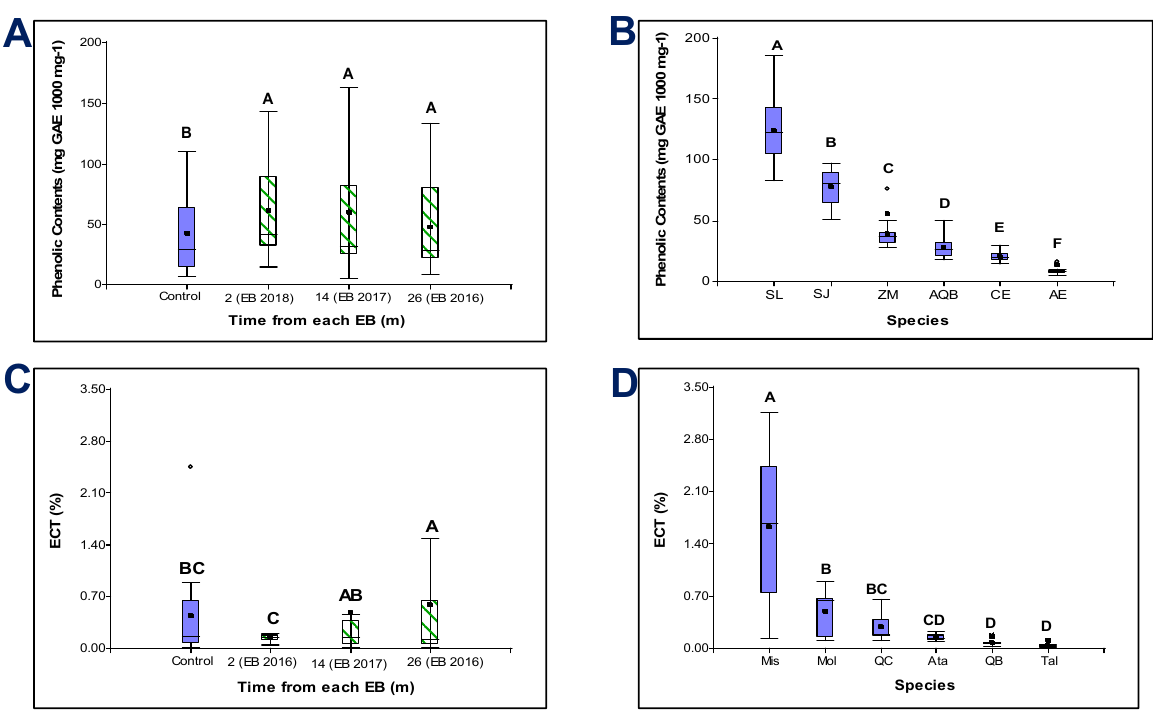
Figure 3. Content of total phenolic compounds (mg of gallic acid 1000 mg − 1 of sample) in response to three experimental burns (EB) from 2016–2018 ( A ); measured in leaves of six woody species from the Western Chaco region, Argentina, collected during November 2018 ( B ). Samples of five individual plants were burnt in three different experimental burns (EB). Concentration of extractable condensed tannin (ECT, %) in response to three experimental burns (EB) from 2016–2018 ( C ); measured in leaves of six woody species from the Western Chaco region, Argentina, collected during November 2018 ( D ). Samples of five individual plants were burnt in three different experimental burns (EB). Each EB was performed at the end of fire season (September or October) in a different year (2016, 2017, and 2018). Any plant was burnt twice. In the box plot, the boundary of the box closest to zero indicates the first quartile (Q1), a black line within the box marks the median, a black point within the box marks the mean, and the boundary of the box farthest from zero indicates the third quartile (Q3). Whiskers above and below the box indicate the 10th and 90th percentiles. Different letters indicate significant differences between sampling dates, according to LSD Fisher pairwise comparison procedure with α : 0.05, n = 30 individual plants in each EB and 30 individual plants as control. References: SL = S. lorentzii , SJ = S. johnstonii , SM = S. mistol , AQB = A. quebracho-blanco , CE = C. ehrenbergiana , AE = A. emarginata